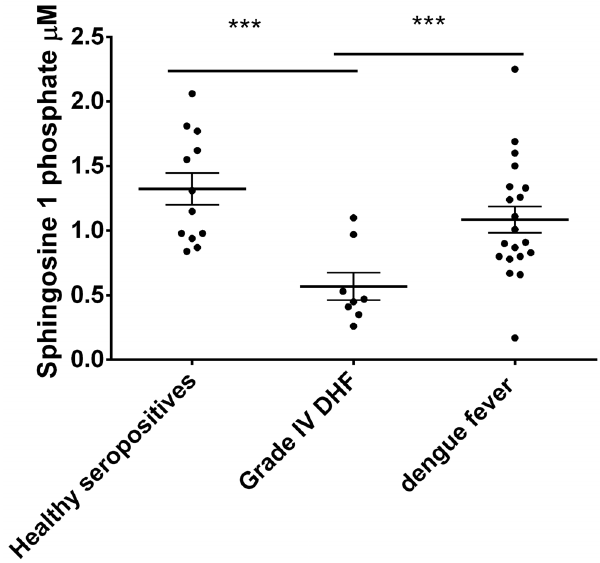
Figure 1. S1P levels in patients with grade IV DHF, patients with DF and healthy individuals. Serum S1P was measured by quantitative ELISA in individuals with grade IV DHF (n=8), DF (n=20) and healthy controls (n=12). The lines represent the mean and the error bars represent the standard error of mean. ***p=0.005. doi:10.1371/journal.pone.0113394.g001 PLOS ONE |